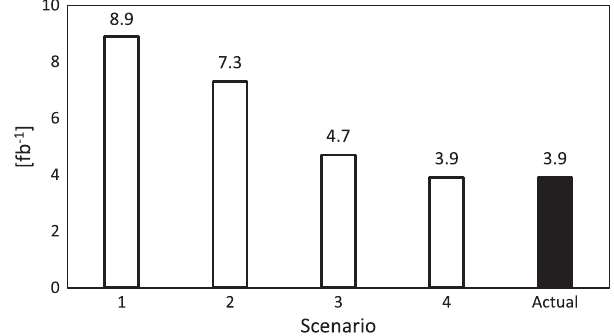
FIG. 12. Predictions for integrated luminosity production in the LHC during 2015 reference period compared to actual